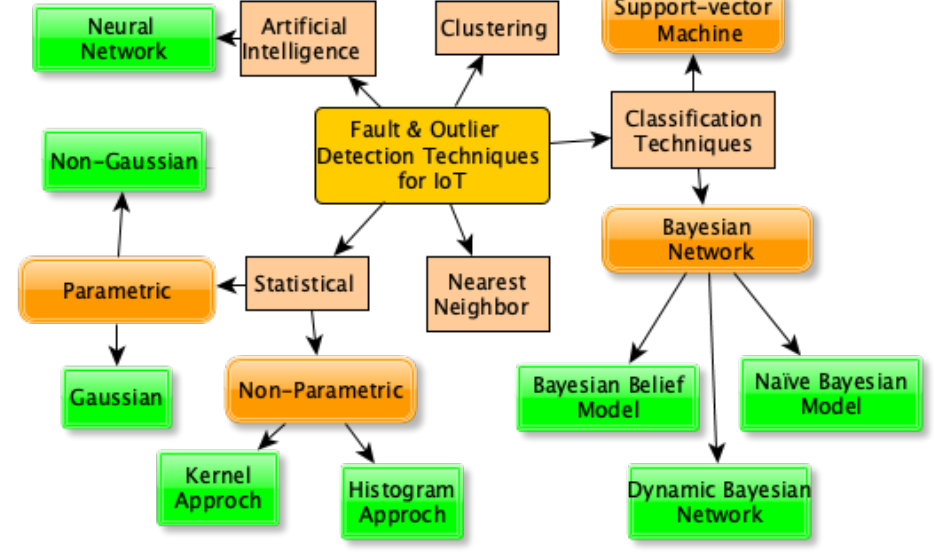
Figure 5. Taxonomy of fault and outlier detection models for